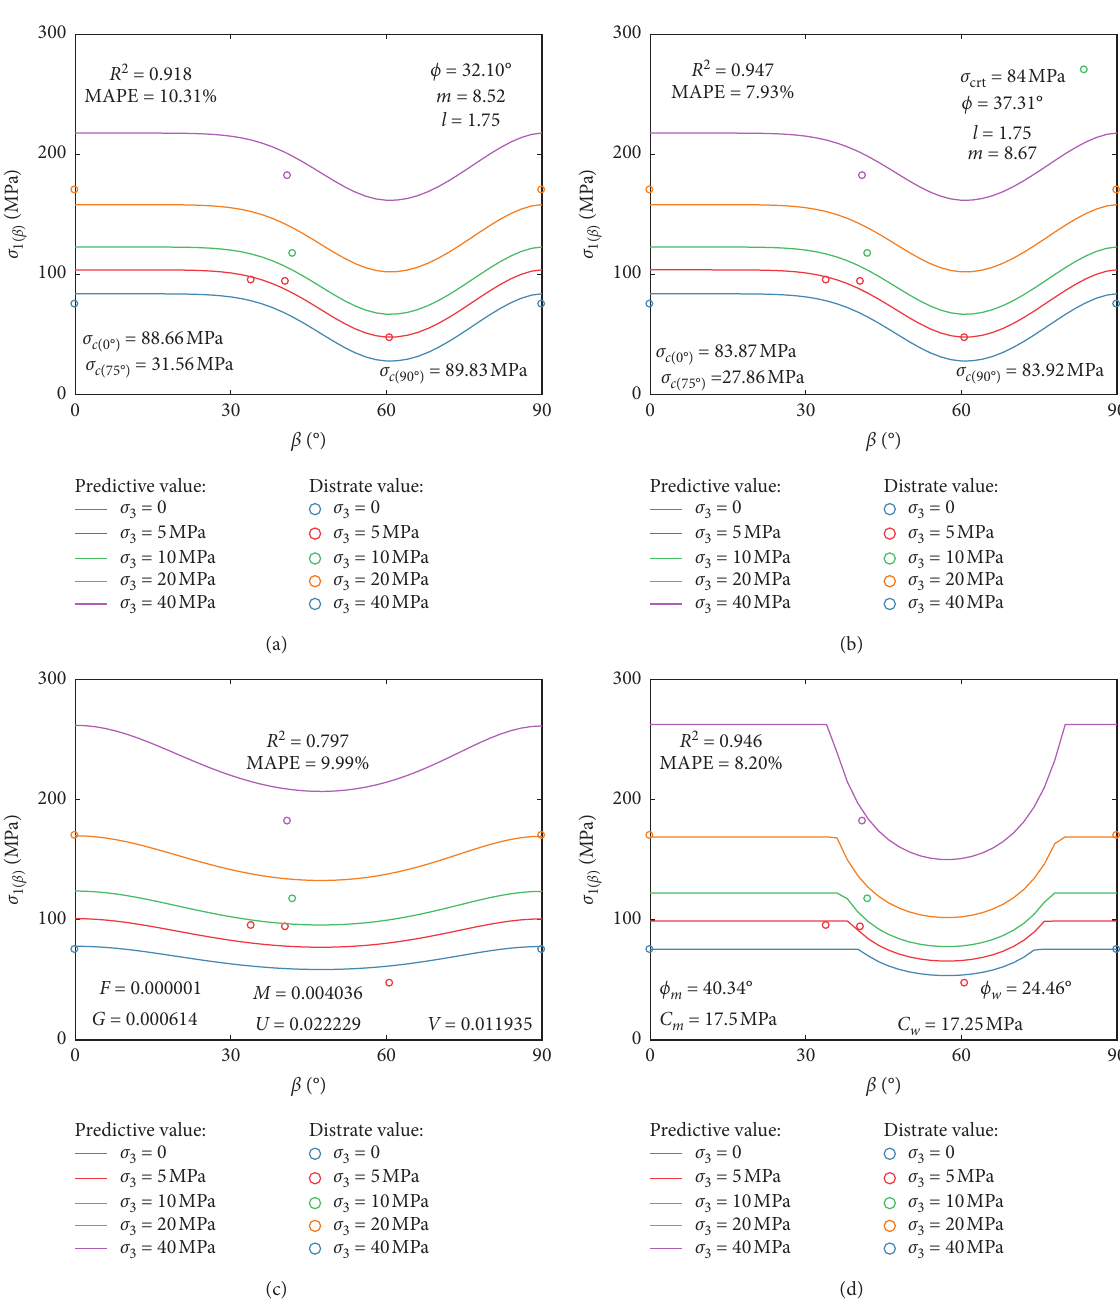
Figure 15: Predicted strength of the bedded marble and the material coefficients of the four criteria. (a) LEE. (b) NLEE. (c) Pariseau ( n � 1). (d)